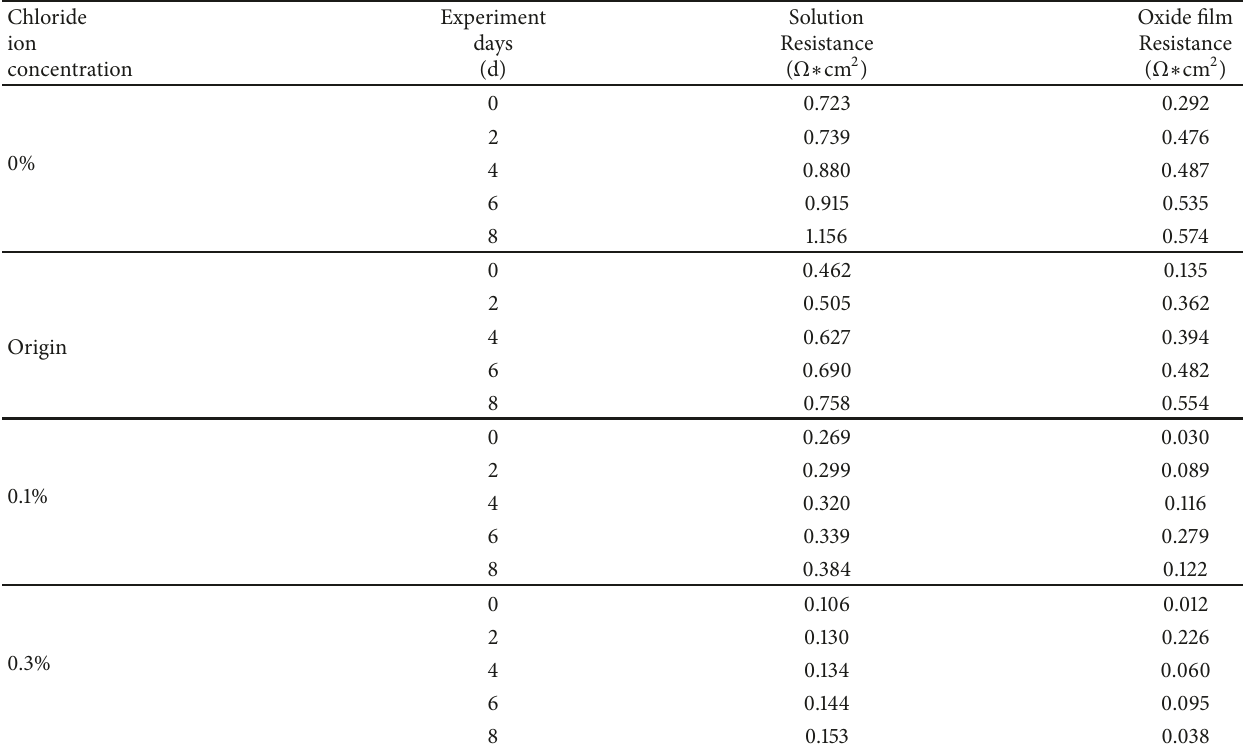
Table 8: The resistance parameters of the fitted equivalent